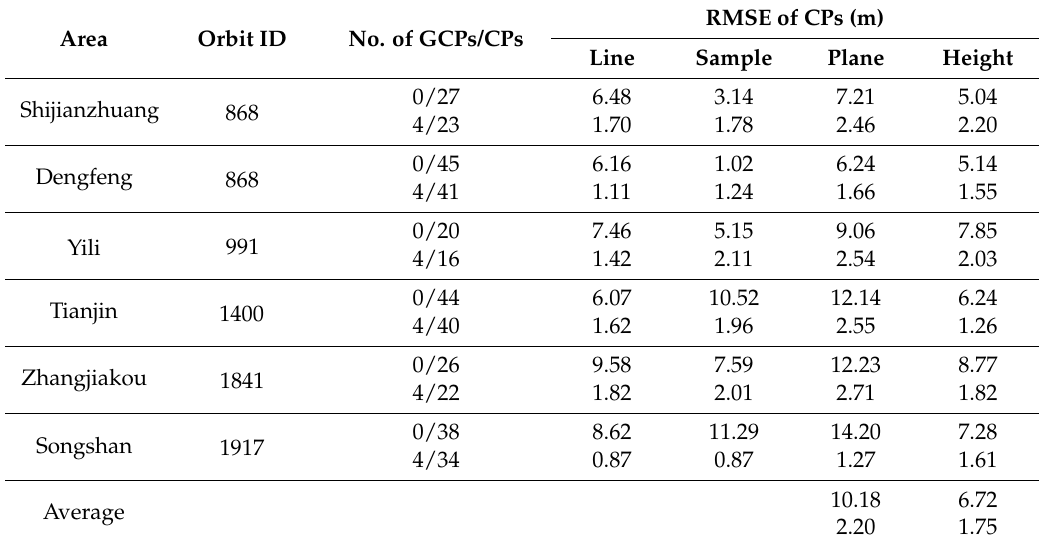
Table 8. Results for planimetric and height accuracy based on bundle adjustment in six representative